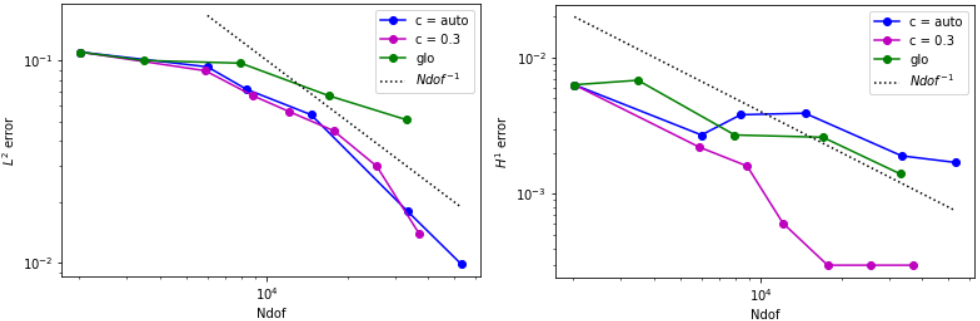
Figure 20. Error behavior for example 3 when η N is adopted. ( Left ) The estimated L 2 norm of the error is displayed. ( Right ) The estimated H 1 seminorm is